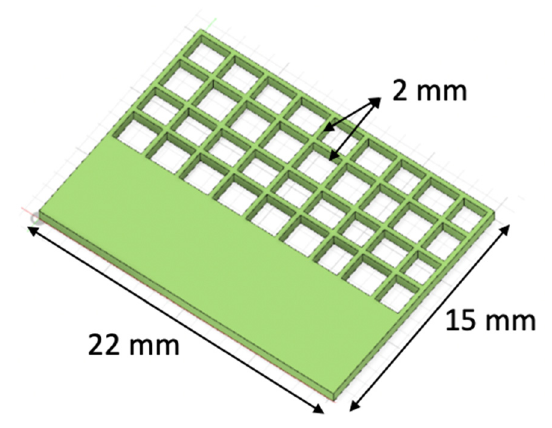
Figure 2. CAD model of the printed constructs.